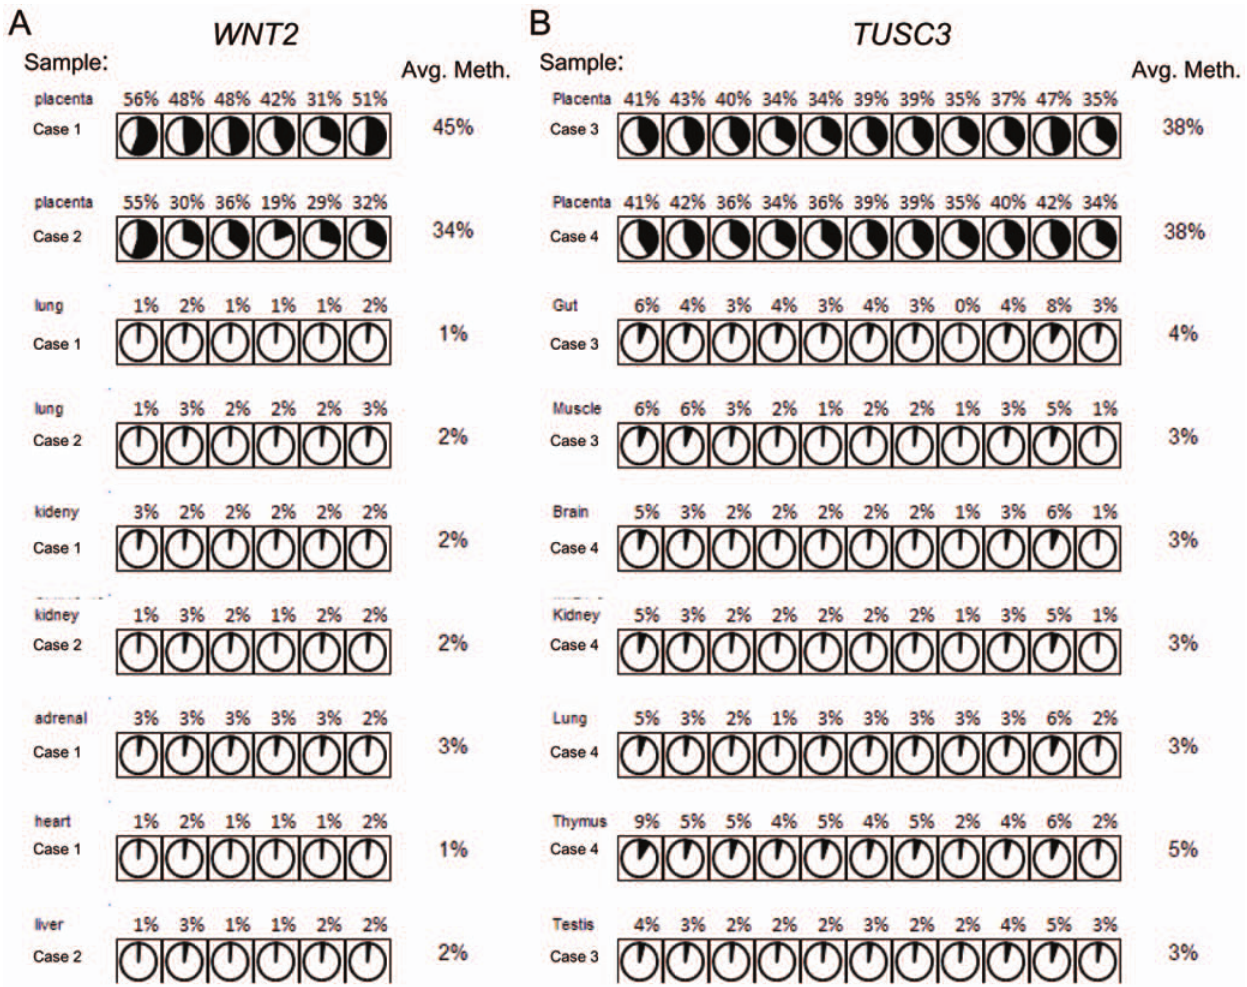
Figure 6. Tissue-specific DNA methylation of WNT2 and TUSC3 . (A) DNA samples from two independent fetuses associated with placental methylation at the WNT2 promoter were investigated by bisulfite pyrosequencing. None of the tissues (lung, kidney, adrenal, heart and liver) other than placenta was methylated. (B) DNA samples from two independent fetuses with placental methylation at the TUSC3 promoter were investigated by bisulfite pyrosequencing. None of the tissues (lung, kidney, gut, muscle, brain, thymus and testis) other than placenta was methylated. Each circle represents a CpG site in a sample. Area shaded in black is proportional to the methylation level of the CpG site indicated by pyrosequencing.